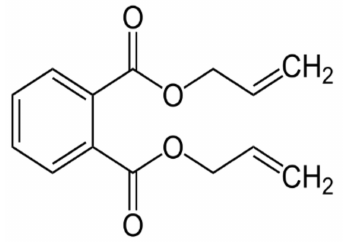
Figure 1. Structure of Diallyl Phthalate